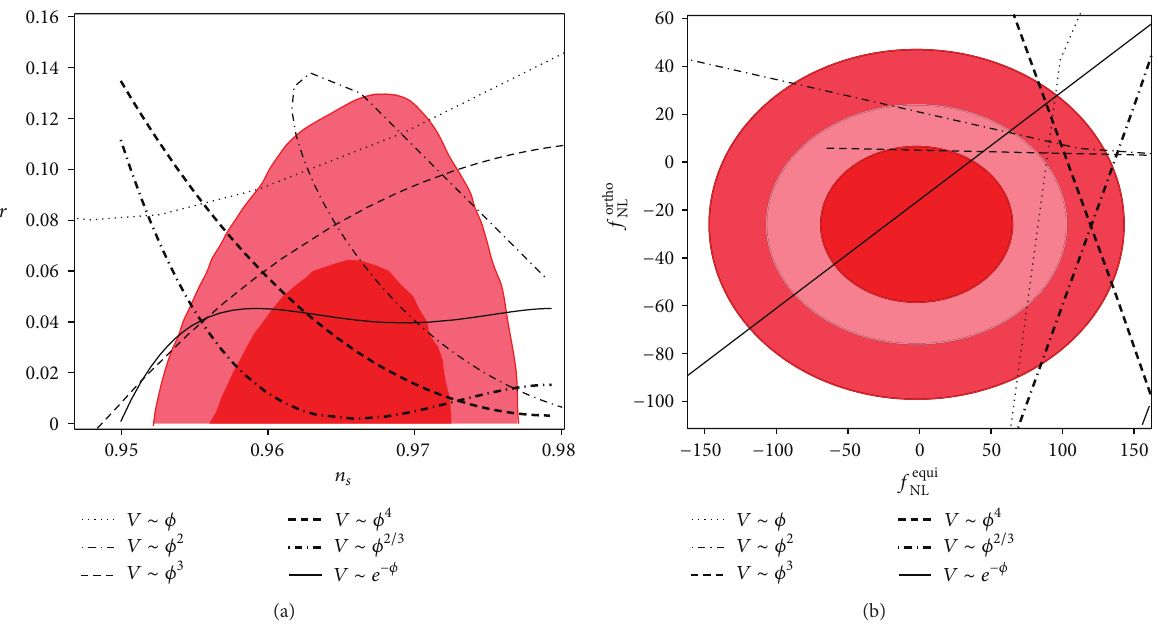
Figure 4: Tensor-to-scalar ratio versus the scalar spectral index for an inflationary model in which both inflaton and its derivative are nonminimally coupled to gravity, in the background of Planck 2015 TT, TE, and EE + lowP data (a) and the amplitude of the orthogonal configuration versus the amplitude of the equilateral configuration of non-Gaussianity for an inflationary model in which both inflaton and its derivative are nonminimally coupled to gravity, in the background of Planck 2015 TTT, EEE, TTE, and EET data (b). Figure is plotted with 𝑛 = 2 , 𝑓(𝜙) ∼ 𝜉𝜙 4 , and various types of potential, for 𝑁 = 60 .